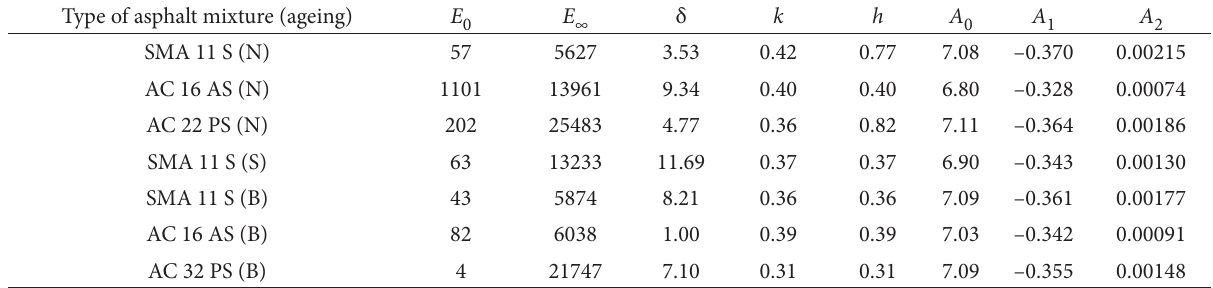
Table 3. The coefficients for Huet-Sayegh model at 20 °C reference temperature Type of asphalt mixture (ageing)